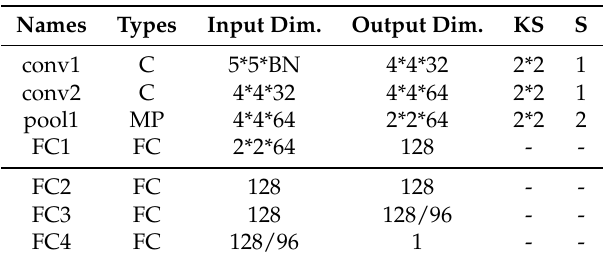
Table 2. Layer parameters of